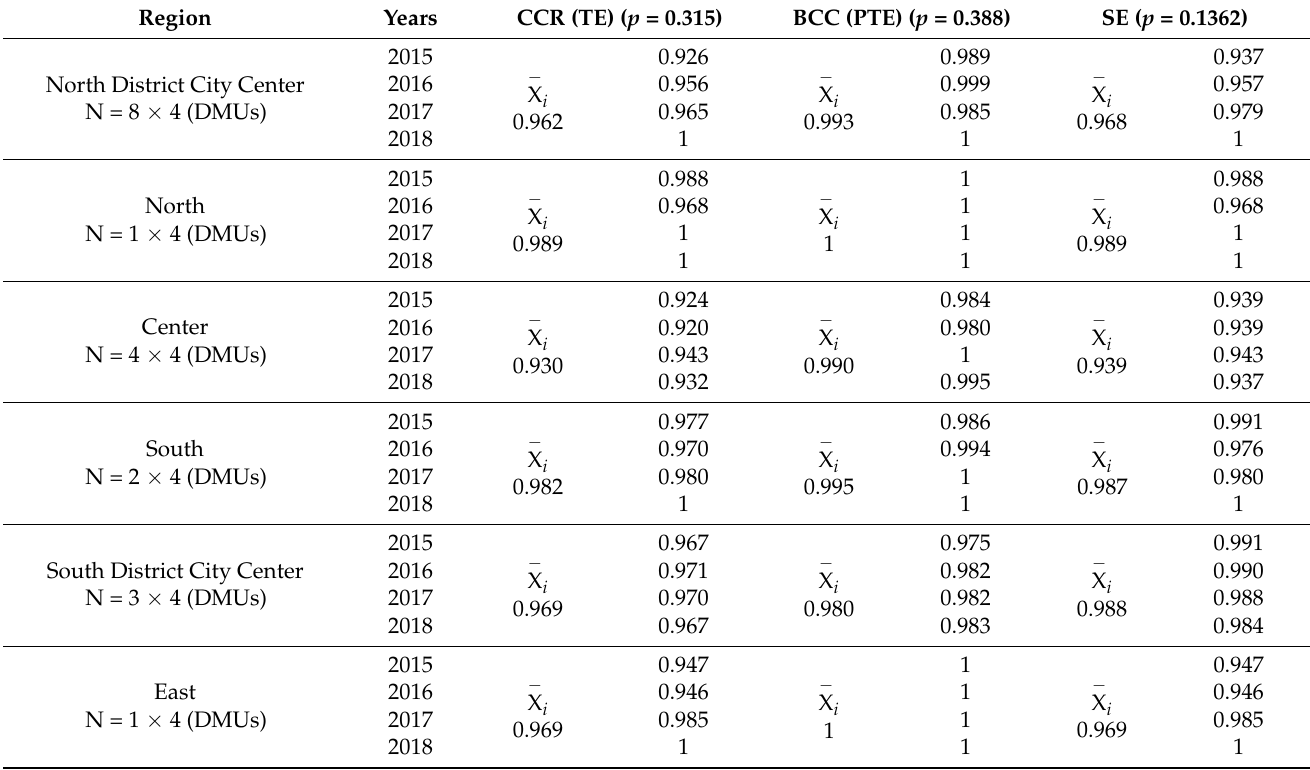
Table 8. The DEA average efficiency value with different region tertiary